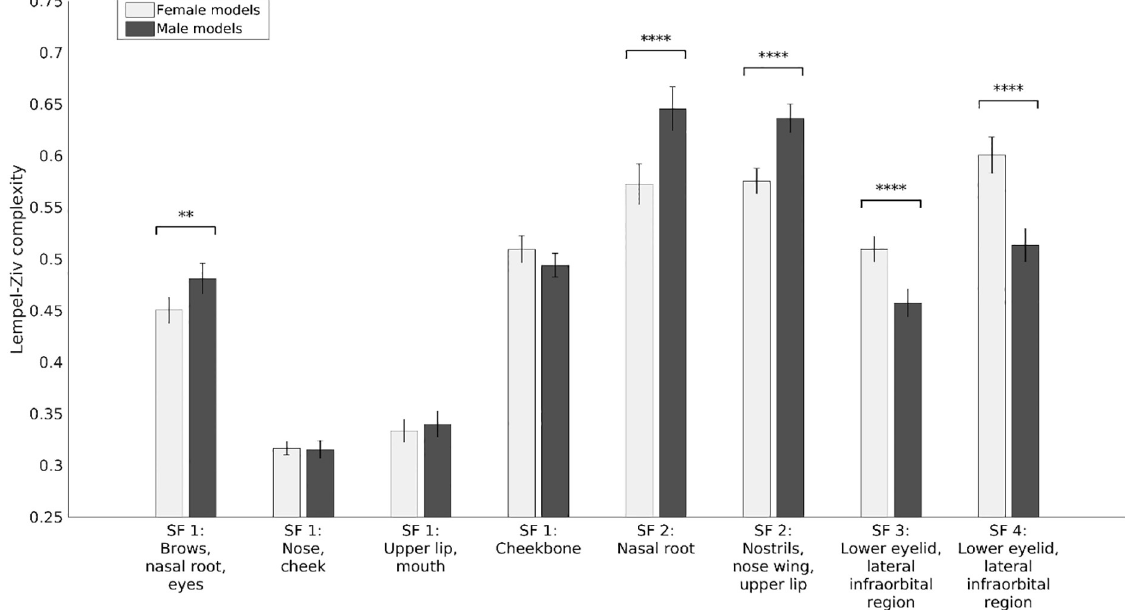
Fig 9. Lempel-Ziv complexity for female and male models for the significant areas from the analysis of similarity. Error bars represent 95% confidence intervals. �� p < .01. ���� p < .0001.